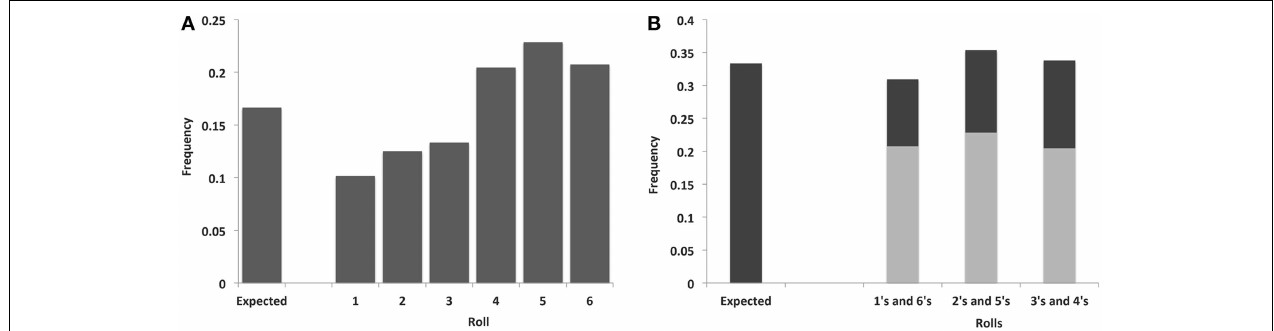
FIGURE 2 | Frequency distribution of reported rolls. (A) by individual number and (B) combining across paired-opposite numbers. The expected frequency of rolls by chance is plotted on the left of each graph.